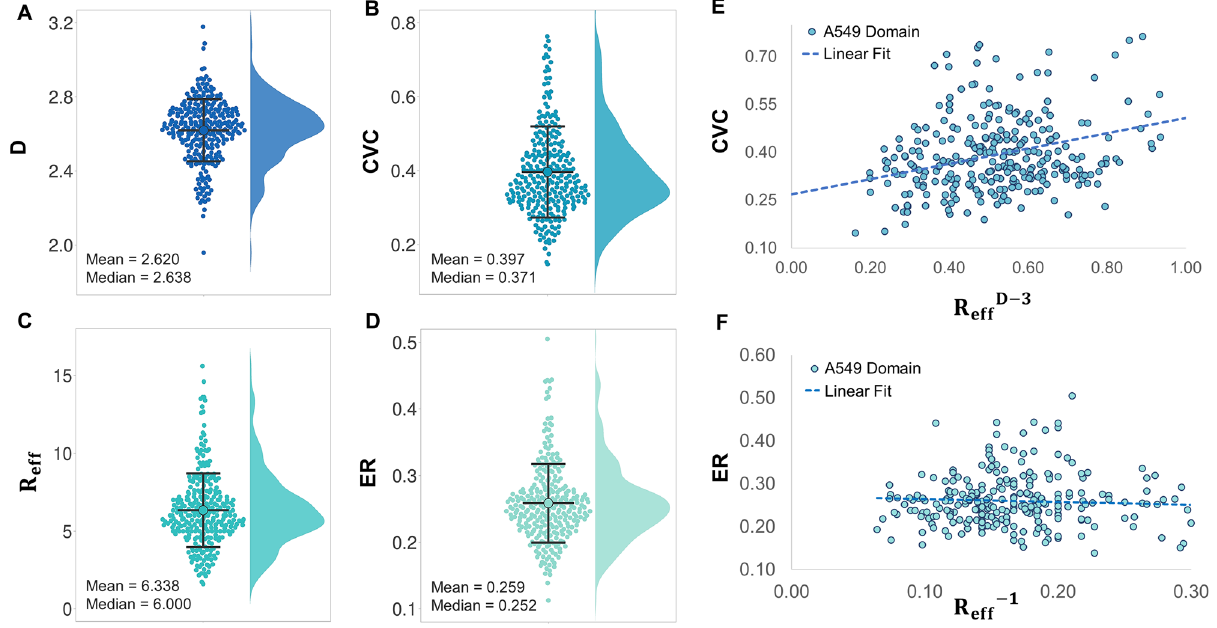
Figure 4. Characterizing morphological properties of chromatin packing domains in A549 cells. A total of 280 A549 cell packing domains were analyzed ( A ) Chromatin packing scaling D distribution was calculated for A549 cells. The median of the wide distribution is equal to 2.64. ( B ) Chromatin volume concentration (CVC) distribution per packing domain. We observed the CVC distribution ranges from 0.15 to 0.92 with a median value of 0.37 for A549 cells. ( C ) Effective domain size R eff for A549 cells. The effective domain size is the ratio between domain size R f and domain fiber size R min . For A549 domains, the median R min (IQR) is 11.6 (10–14) nm. ( D ) Exposure Ratio (ER) is defined as the fraction of chromatin voxels on the surface of the interchromatin voids compared to the entire volume. For A549 domains, the median ER ranges from 0.11 to 0.50 with a median value of 0.25. ( E ) A moderate correlation between domain CVC and D has been observed for A549 cells, with r = 0.3. ( F ) Exposure ratio is negatively and weakly correlated with inverse effective domain size for A549, with r =